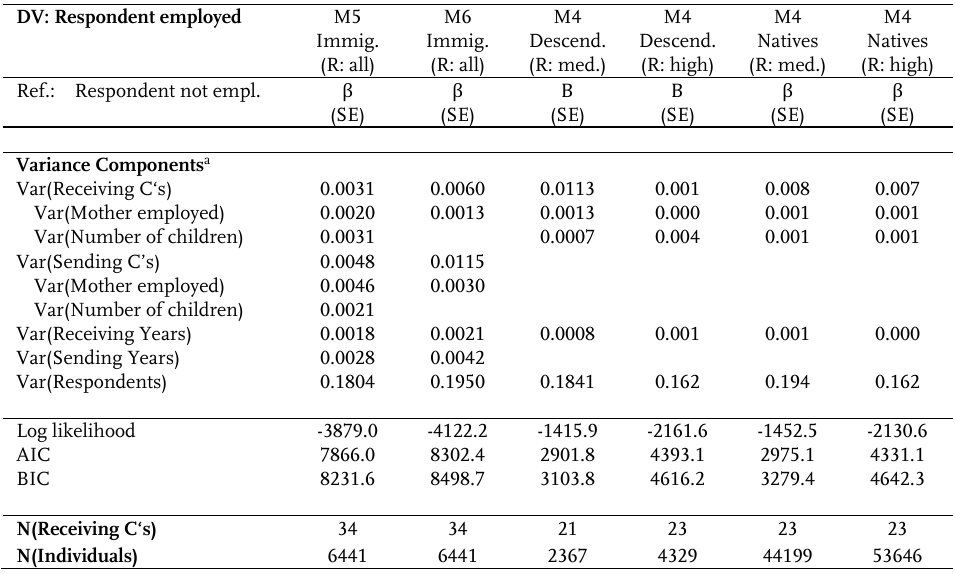
Full models M5 and M6 for immigrants, M4 for descendants and natives